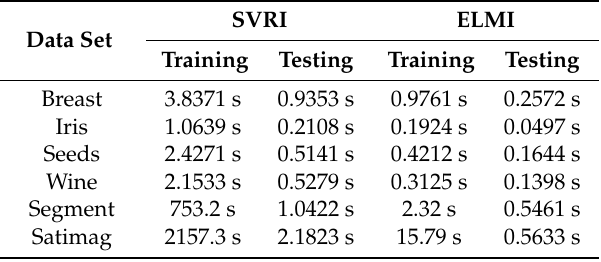
Table 3. The comparison of training and testing time of SVRI and